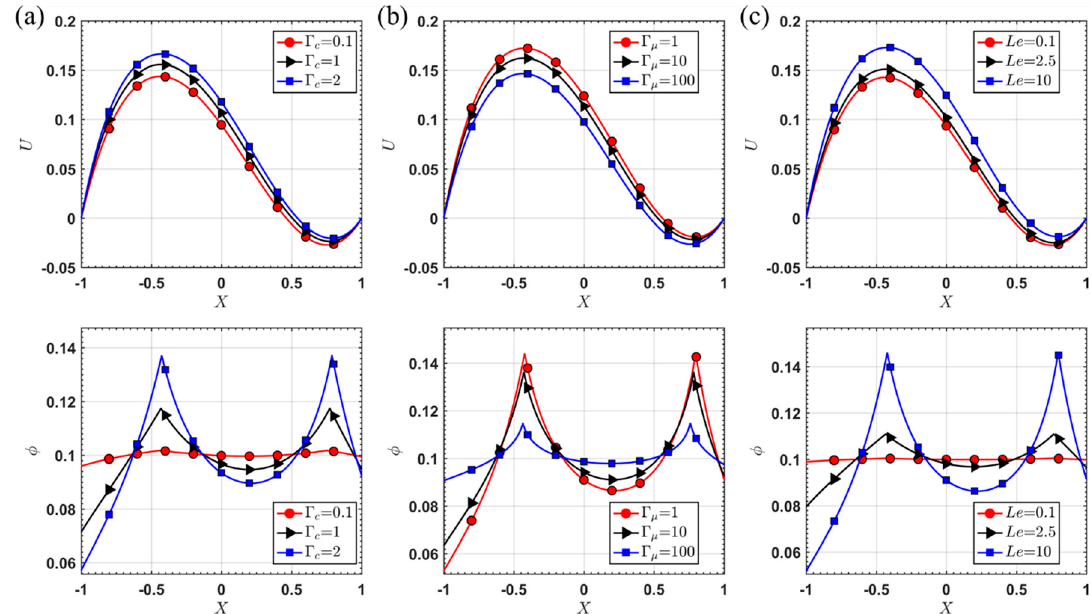
Figure 4. ( a ) E ff ect of Γ c on the velocity, and concentration, when Γ µ = 0.1, Le = 10, n = − 0.5, δ = 1, Ra = 3, Br = 5 and φ avg = 0.1. ( b ) E ff ect of Γ µ on the velocity, and concentration, when Γ c = 2.5, Le = 10, n = − 0.5, δ = 1, Ra = 3, Br = 5 and φ avg = 0.1. ( c ) E ff ect of Le on the velocity, and concentration, when Γ c = 2.5, Γ µ = 0.1, n = − 0.5, δ = 1, Ra = 3, Br = 5 and φ avg = 0.1.